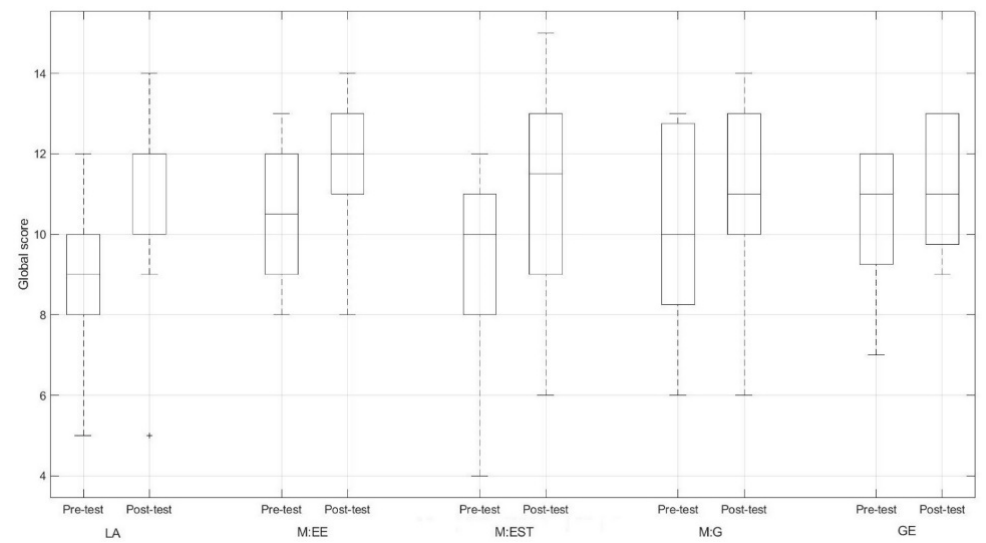
Figure 5. Global STAT scores in the pre- and post-test for each course.